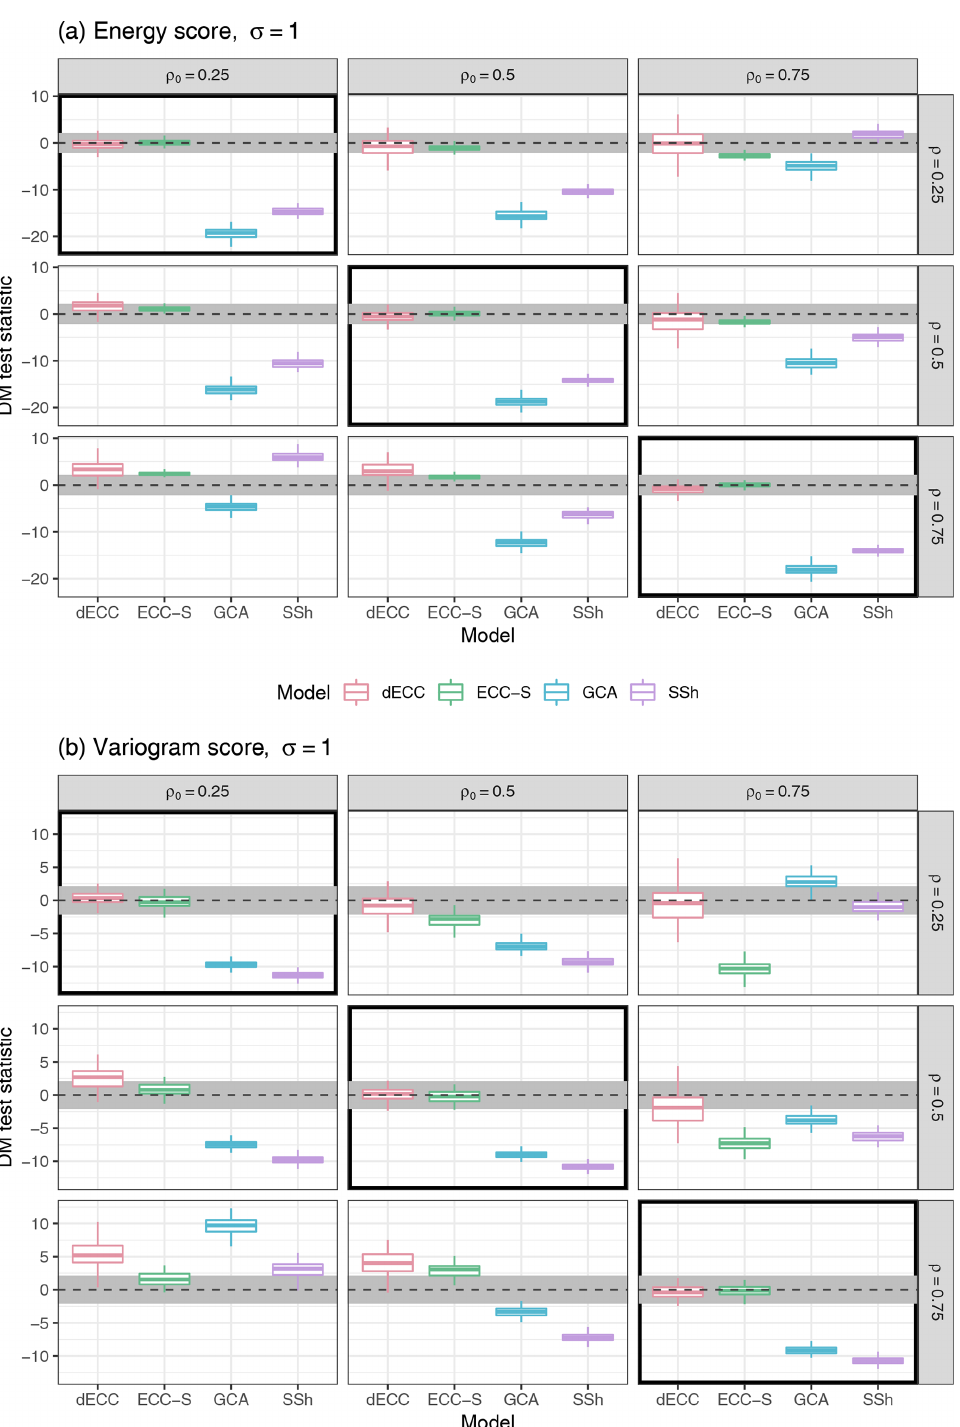
Figure 6. Summaries of DM test statistic values based on the ES (a) and the VS (b) for Setting 3A with (cid:15) = 1 and σ = 1. ECC-Q forecasts are used as a reference model such that positive values of the test statistic indicate improvements over ECC-Q and negative values indicate deterioration of forecast skill. Boxplots summarize results of the 100 Monte Carlo repetitions of each individual experiment. The horizontal gray stripe indicates the acceptance region of the two-sided DM test under the null hypothesis of equal predictive performance at a level of 0.05. Simulation parameter choices where the correlation structure of the raw ensemble is correctly specified ( ρ = ρ 0 ) are surrounded by black